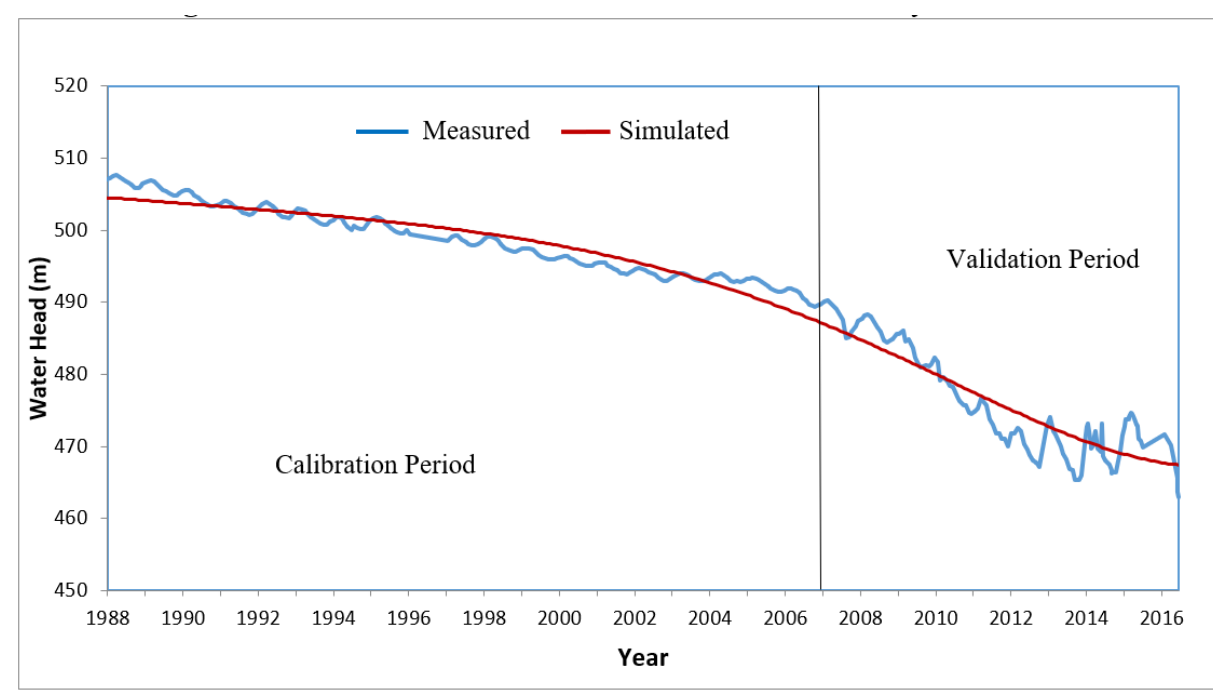
Figure 10. The comparison of observed and simulated fluctuations in G.W. heads in the observation well (AL1043).